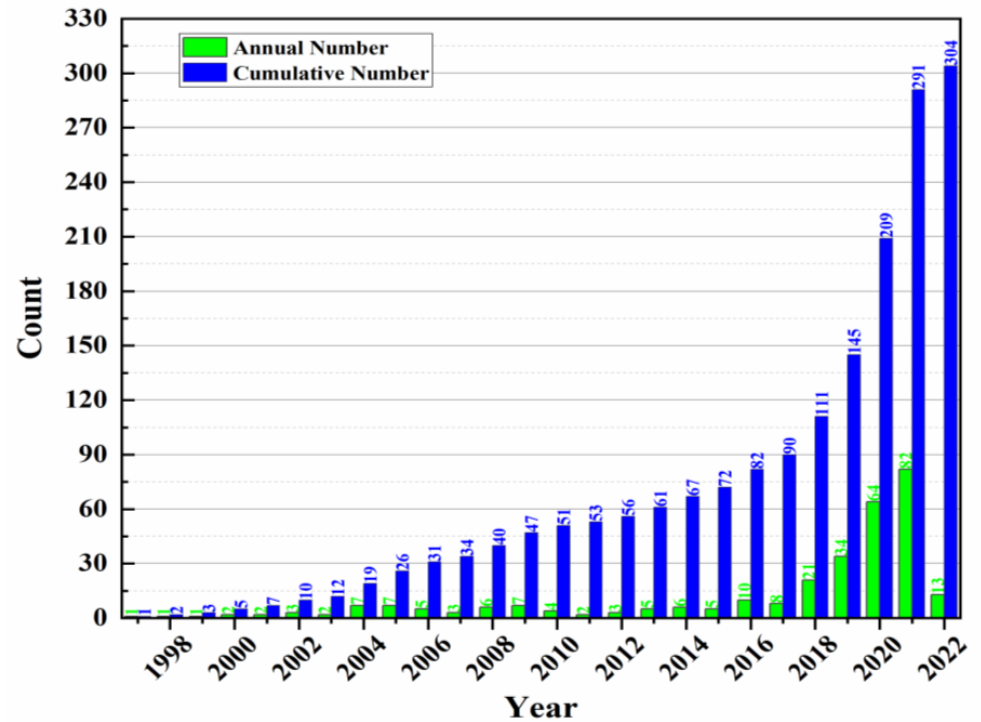
Figure 3. Annual and cumulative numbers of papers published on perovskite X-ray detectors from 1997 to 2022.